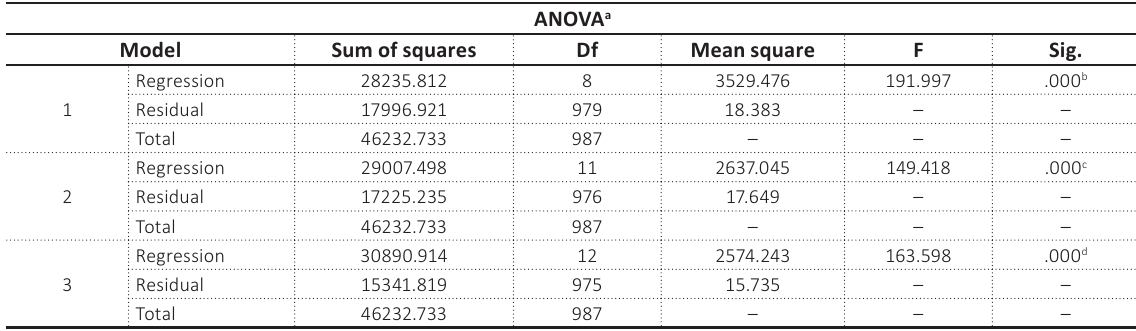
Source: Field survey results